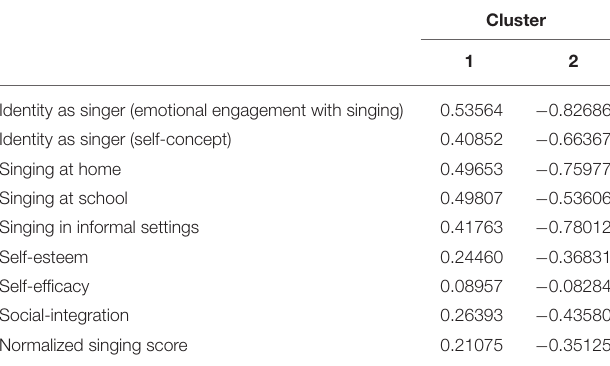
TABLE 2 | Final cluster